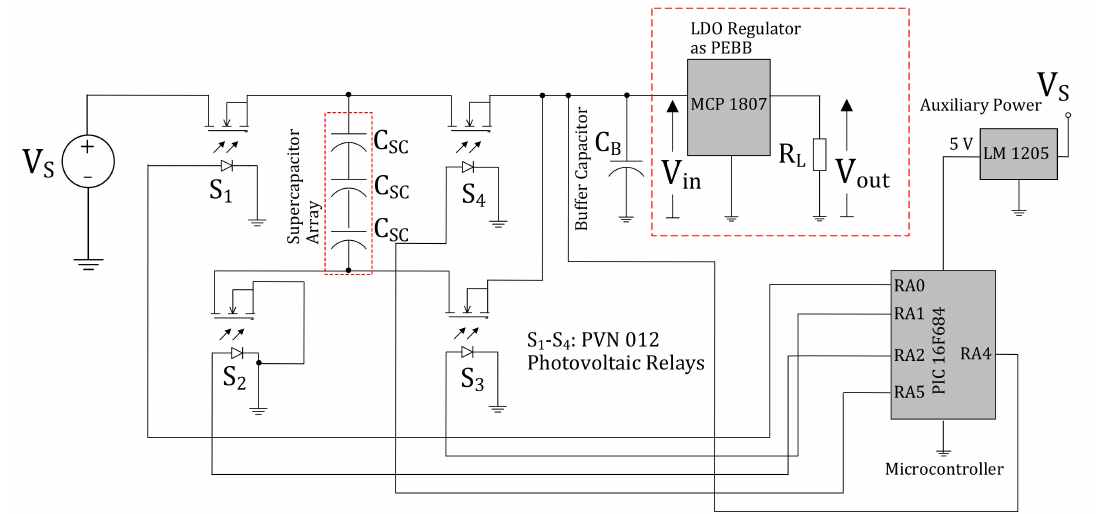
Figure 8. Schematic of a 12–5 V discrete component-based SCALDO regulator